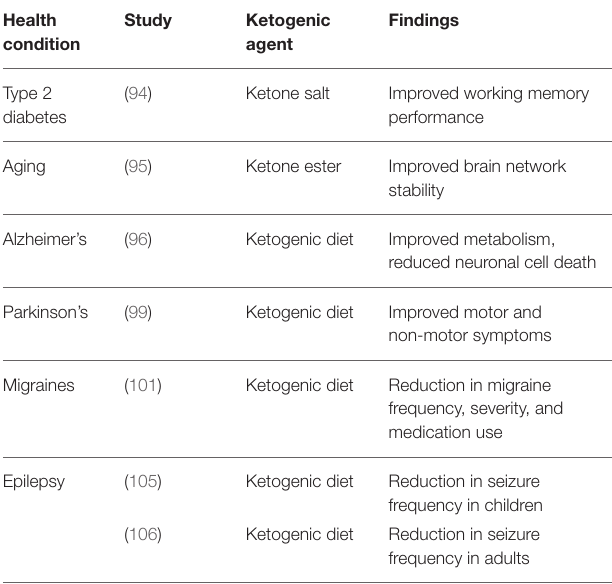
TABLE 3 | A summary of how ketones have been used in health conditions relating to TBI